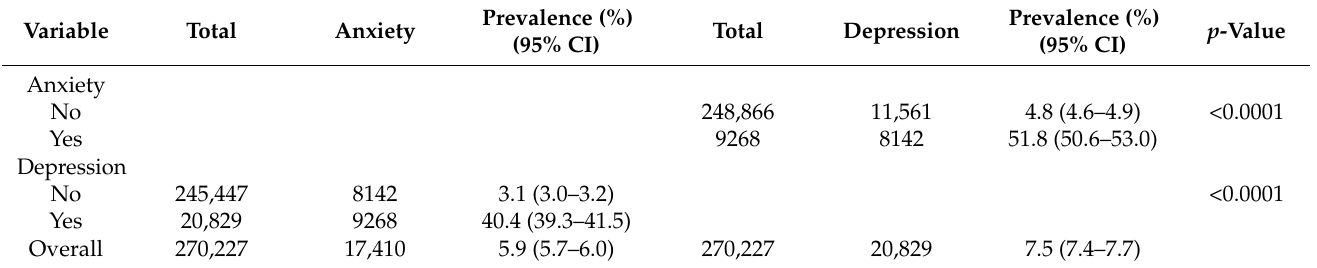
Table 1. Prevalence of anxiety, depression, and comorbidity (%).